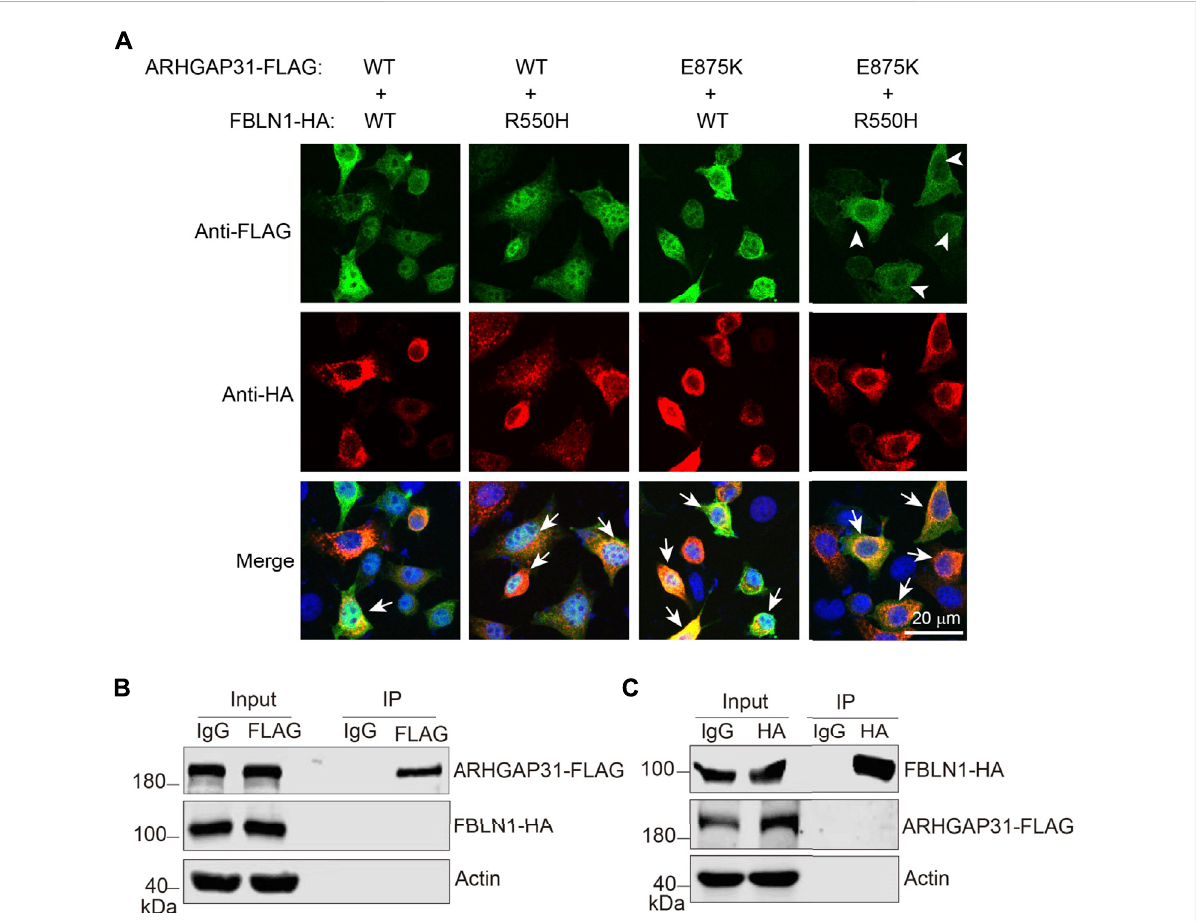
FIGURE 5 Increased colocalization with mutant ARHGAP31 and FBLN1. (A) Representative immuno fl uorescence staining of exogenous ARHGAP31 and FBLN1 in co-transfected HeLa cells. Green, anti-FLAG staining; red, anti-HA staining; and blue, DAPI-labeled nuclei. Arrowheads indicate cells with apparent non-nuclear expression of ARHGAP31, and arrows indicate recognizable cells with co-localized target proteins. (B) HeLa cells were co-transfected with ARHGAP31-FLAG and FBLN1-HA, and co-immunoprecipitation was performed using anti-FLAG antibody followed by detection withanti-HAantibody. (C) ARHGAP31-FLAG andFBLN1-HA co-transfected cellswerelyzed,and co-immunoprecipitationwasperformed using anti-HA antibody followed by immunoblotting with anti-FLAG